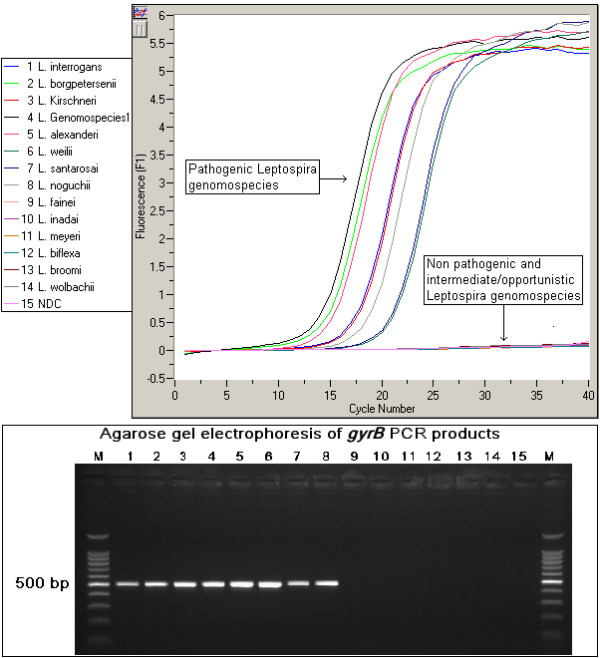
Real-time PCR amplification of the gyrB gene from 14 Leptospira genomospecies. Agarose gel electrophoresis of the PCR products from the PCR are also shown below. Lanes: M, 100 bp DNA ladder (Promega); 1, L. interrogans sv. Australis; 2, L. borgpetersenii sv. Ballum; 3, L. kirschneri sv. Cynopteri; 4, L. genomospecies 1 sv. Pingchang; 5, L. alexanderi sv. Manzhuang; 6, L. weilii sv. Cellodoni; 7, L. santarosai sv. Shermani; 8, L. noguchii sv. Cristobali; 9, L. fainei sv. Hurstbridge; 10, L. inadai sv. Aguarana; 11, L. meyeri sv. Semeranga; 12, L. biflexa sv. Patoc; 13, L. broomi 5099T; 14, L. wolbachii sv. Codice; 15, No DNA control.